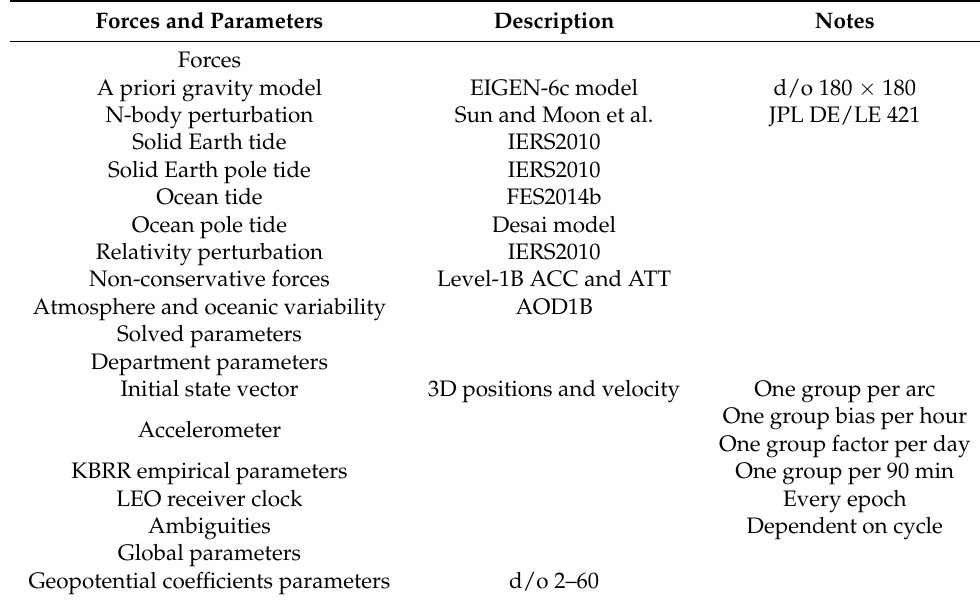
Table 1. Overview of background models and processing